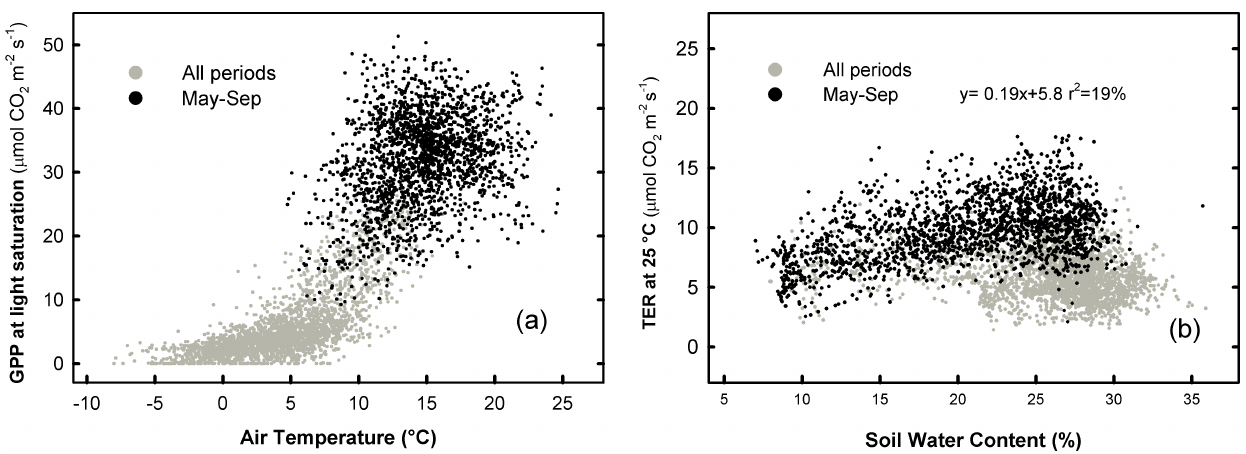
Fig. 8. Comparison of climate variables and the estimated parameters. (a) GPP at light saturation plotted against air temperature. (b) TER at 25 ◦ C plotted against soil water